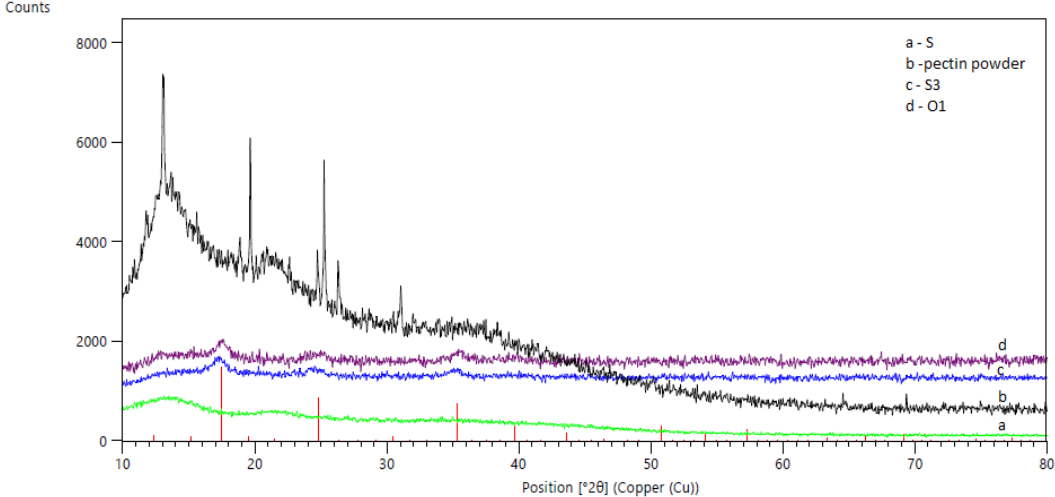
Figure 3. XRD patterns of: ( a ) S pectin-only sorbent, ( b ) pectin powder, ( c ) S3 hybrid sorbent, ( d ) O1 Prussian blue powder.